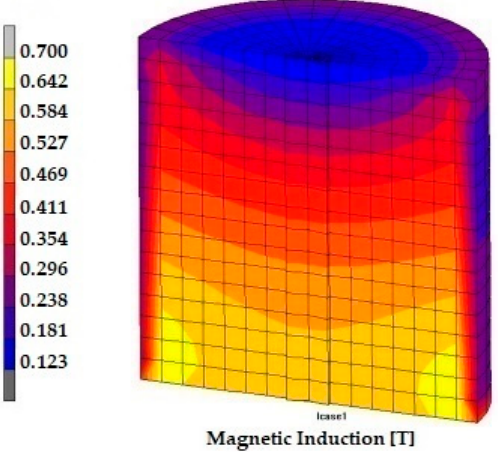
Figure 7. Magnetic induction of the MRE sample in the presence of a magnetic field showing the distribution of magnetic lines force from the bottom to top layer considering the mesh size as boundary layer.